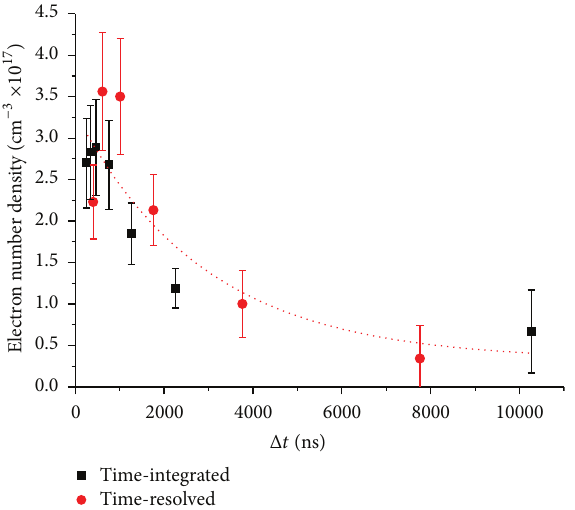
Figure 9: Comparison of plasma electron number density, evalu- atedfromtime-integratedandtime-resolvedspectra.Thedottedline represents the best exponential fit of the